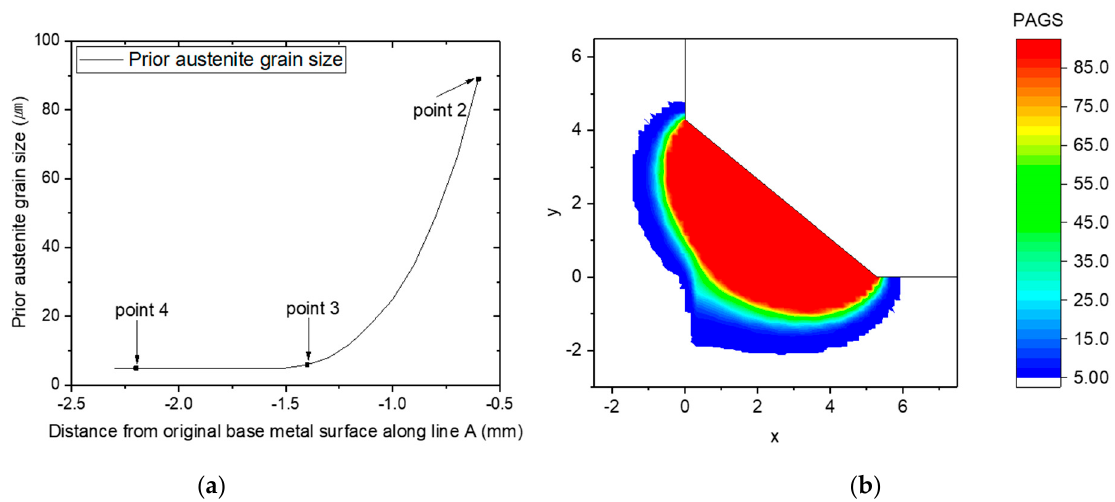
Figure 10. PAGS ( a ) along the line A in Figure 4 and ( b ) mapping of the cross-section.